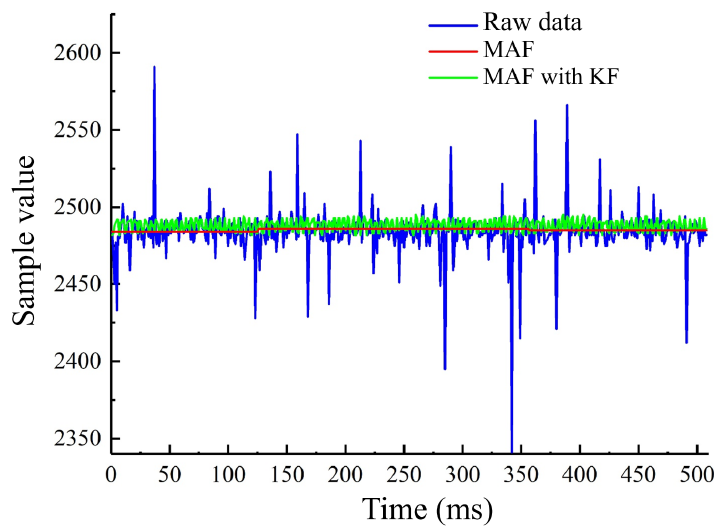
Figure 14. The filtering of the control